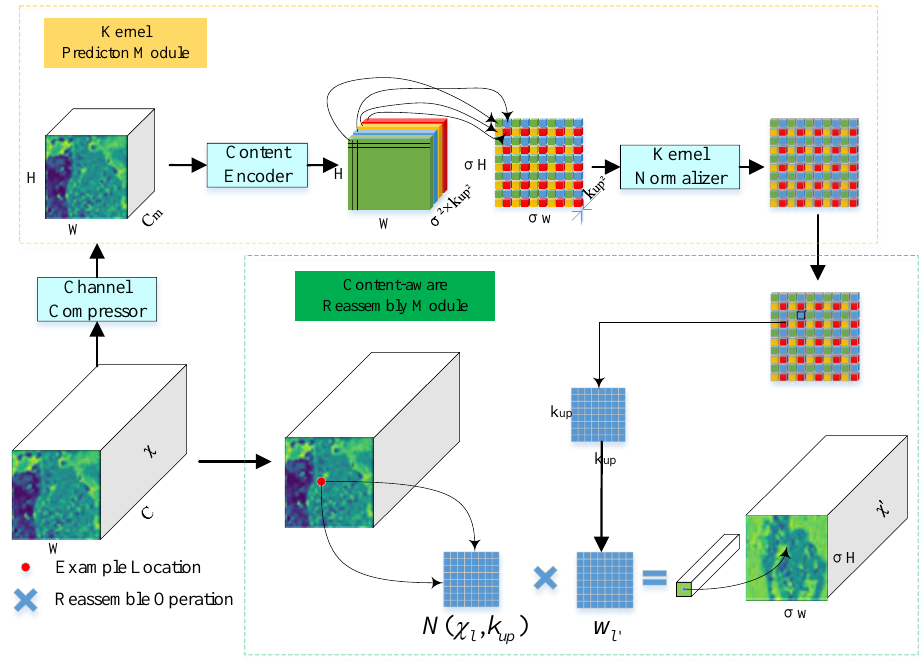
Figure 3. Structure of CARAFE.